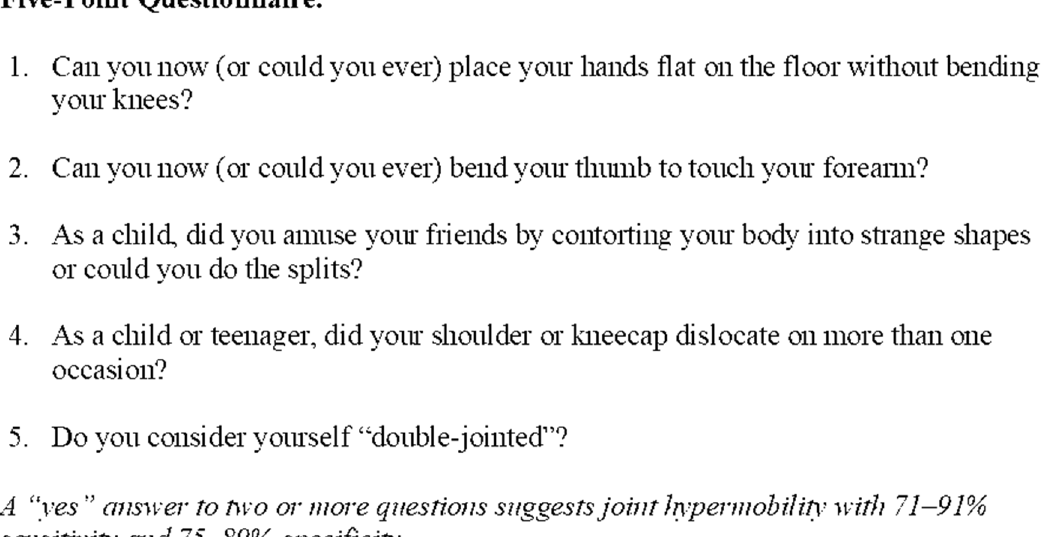
Figure 2. Five-point questionnaire. Adapted from Hakim and Grahame, 2003 [65–67].